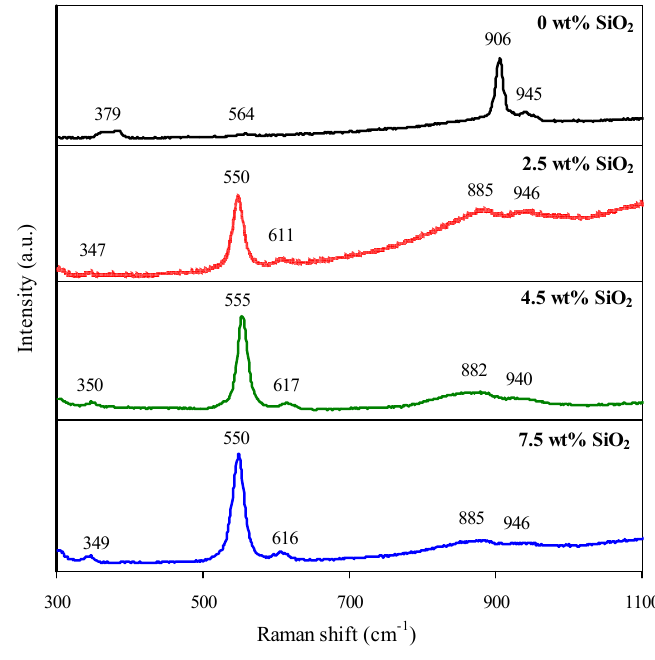
Figure 11. Raman-spectra of catalysts. Catalysts 2016, 6, 162 Figure 11. Raman ‐ spectra of catalysts.